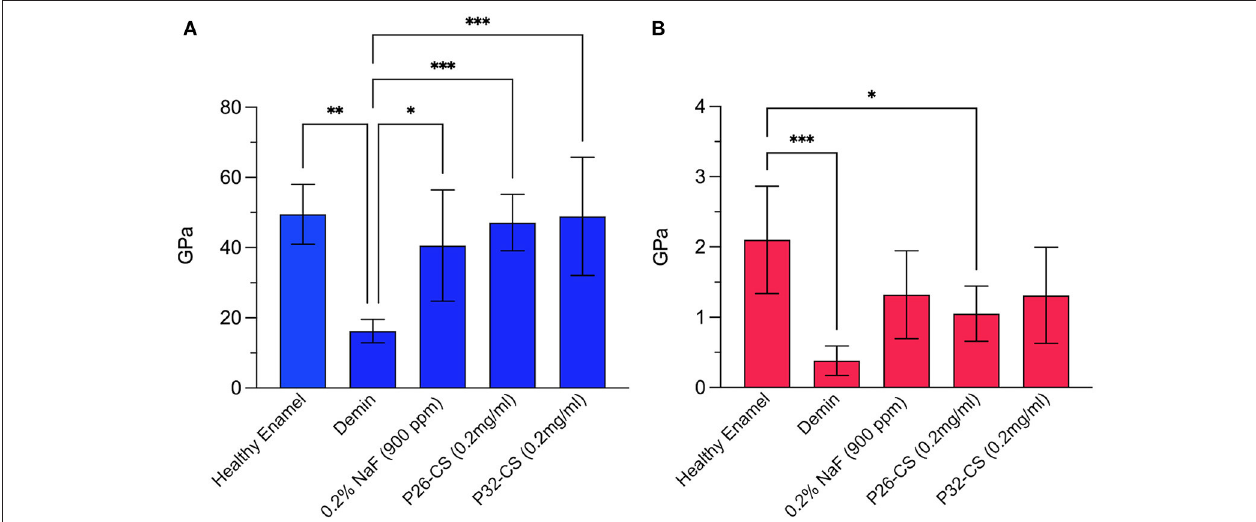
FIGURE 2 | Nanoindentation data showing the modulus (A) and hardness (B) for healthy enamel, demineralized enamel, and samples treated in control (0.2% NaF), P26-CS (0.2 mg/ml) and P32-CS (0.2 mg/ml) hydrogel for 7 days in artificial saliva. The hydrogel applications were made daily. Demin: demineralization (2h). The error bars represent standard deviation ( n = 5–8 per group). Tukey’s multiple comparisons test was applied to identify differences in the hardness and elastic modulus between demineralized and repaired enamel. * ≤ 0.05; ** ≤ 0.01; *** ≤ 0.001.